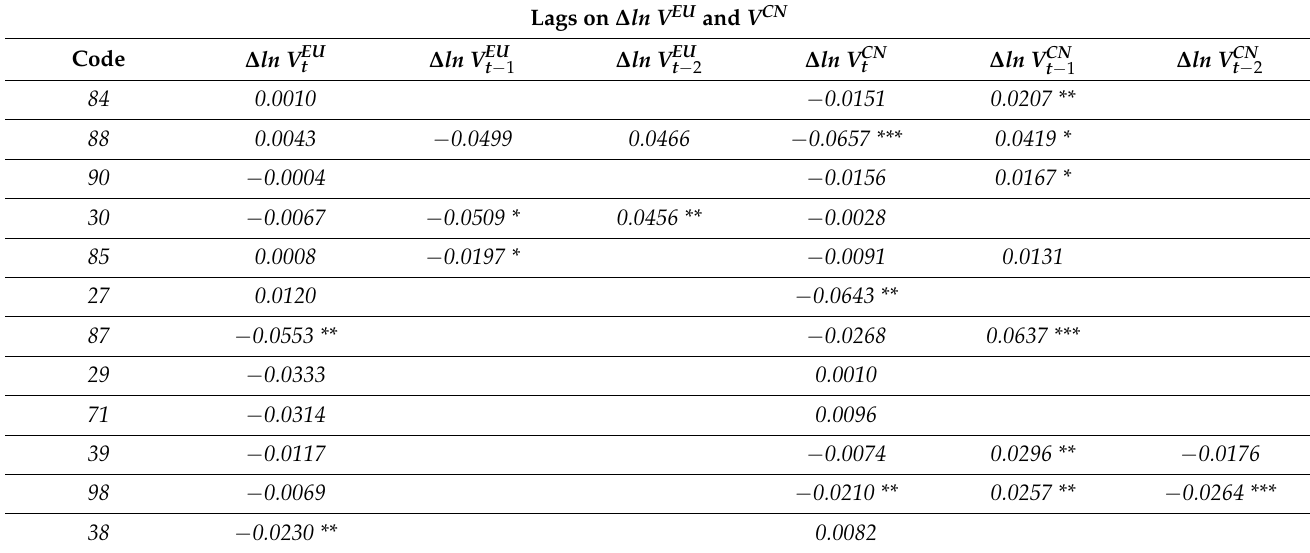
Table 3. Short-run coefficient estimates of volatility for US exports to the EU with third-country effects using the linear ARDL model (5).